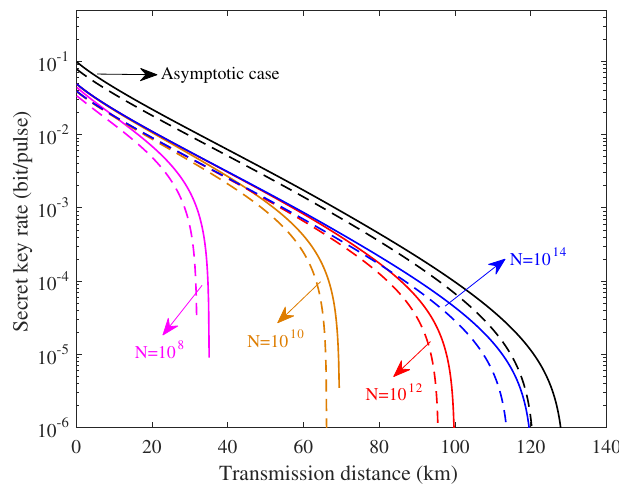
Figure 7. Finite-size key rate of CVQKD involving the ZPC operation for ε = 0.01, where solid lines represent the eight-state DM source preparation and dotted lines represent the four-state DM source preparation, respectively.